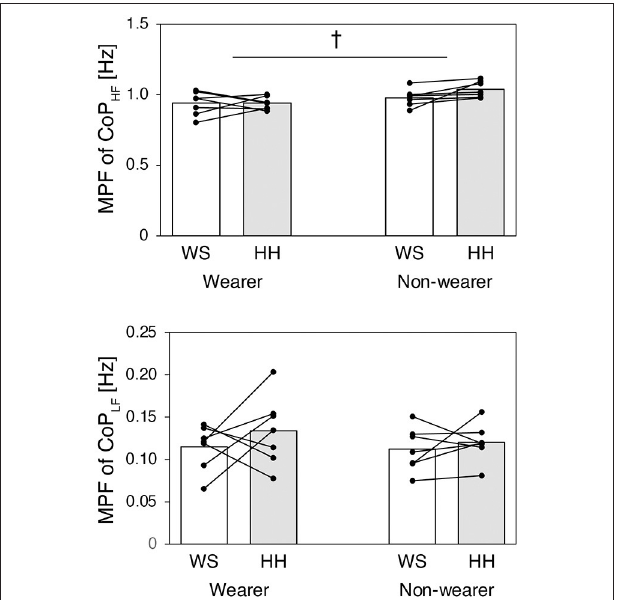
FIGURE 5 | The MPF of CoP HF ( top ) and CoP LF ( bottom ) for each group and each test condition. The white bar indicates the WS condition and the gray bar indicates the HH condition. The small dots represent data for individual † P < participants. 0.05 between the